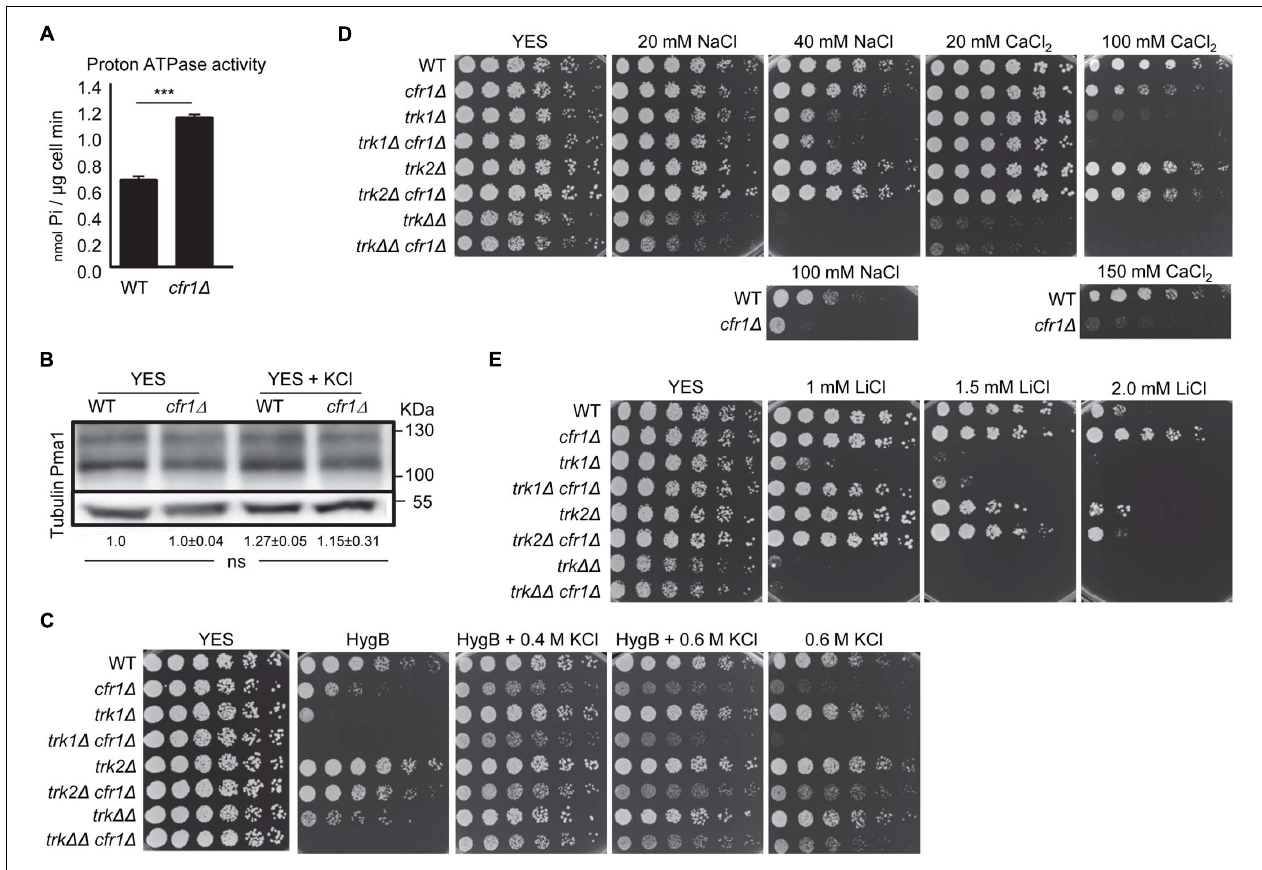
FIGURE 3 | Analysis of membrane polarization in exomer mutants. (A) Measurement of ATPase activity (nmol Pi/ µ g cell minute) in the wild-type (WT) and cfr1 (cid:49) extracts. For each value, the mean of three independent experiments, standard deviation, and statistical significance of the difference, determined using the t -test are shown (*** p < 0.001). (B) Cell extracts from the WT and cfr1 (cid:49) strains, incubated in YES and YES with 0.6 M KCl, were subjected to SDS-PAGE and immunoblotted with polyclonal anti- S. cerevisiae Pma1 (upper panel) and anti-tubulin (lower panel; loading control) antibodies. The relative position of molecular weight markers is indicated on the right (KDa). The intensity of each Pma1 band was relativized to the value for the corresponding tubulin band, and all the values were relativized to the value for the WT grown in YES. For each value, the mean of three independent experiments, standard deviation, and statistical significance of the difference, determined using the Tukey’s multiple comparisons test are shown (ns, non-significant). (C) Cells from the indicated strains were spotted on YES (rich medium) and YES supplemented with 2 µ g/ml hygromycin B (HygB), 2 µ g/ml hygromycin B with KCl, and KCl without hygromycin B. WT, wild-type; trk (cid:49)(cid:49) , trk1 (cid:49) trk2 (cid:49) . (D) The same experimental details as in (C) , but the cells were spotted on YES plates supplemented with different amounts of NaCl and CaCl 2 . The lowest panels show the growth of the WT and cfr1 (cid:49) on plates supplemented with high concentrations of the same compounds. (E) The same experimental details as in (C) , but the cells were spotted on YES plates supplemented with different amounts of